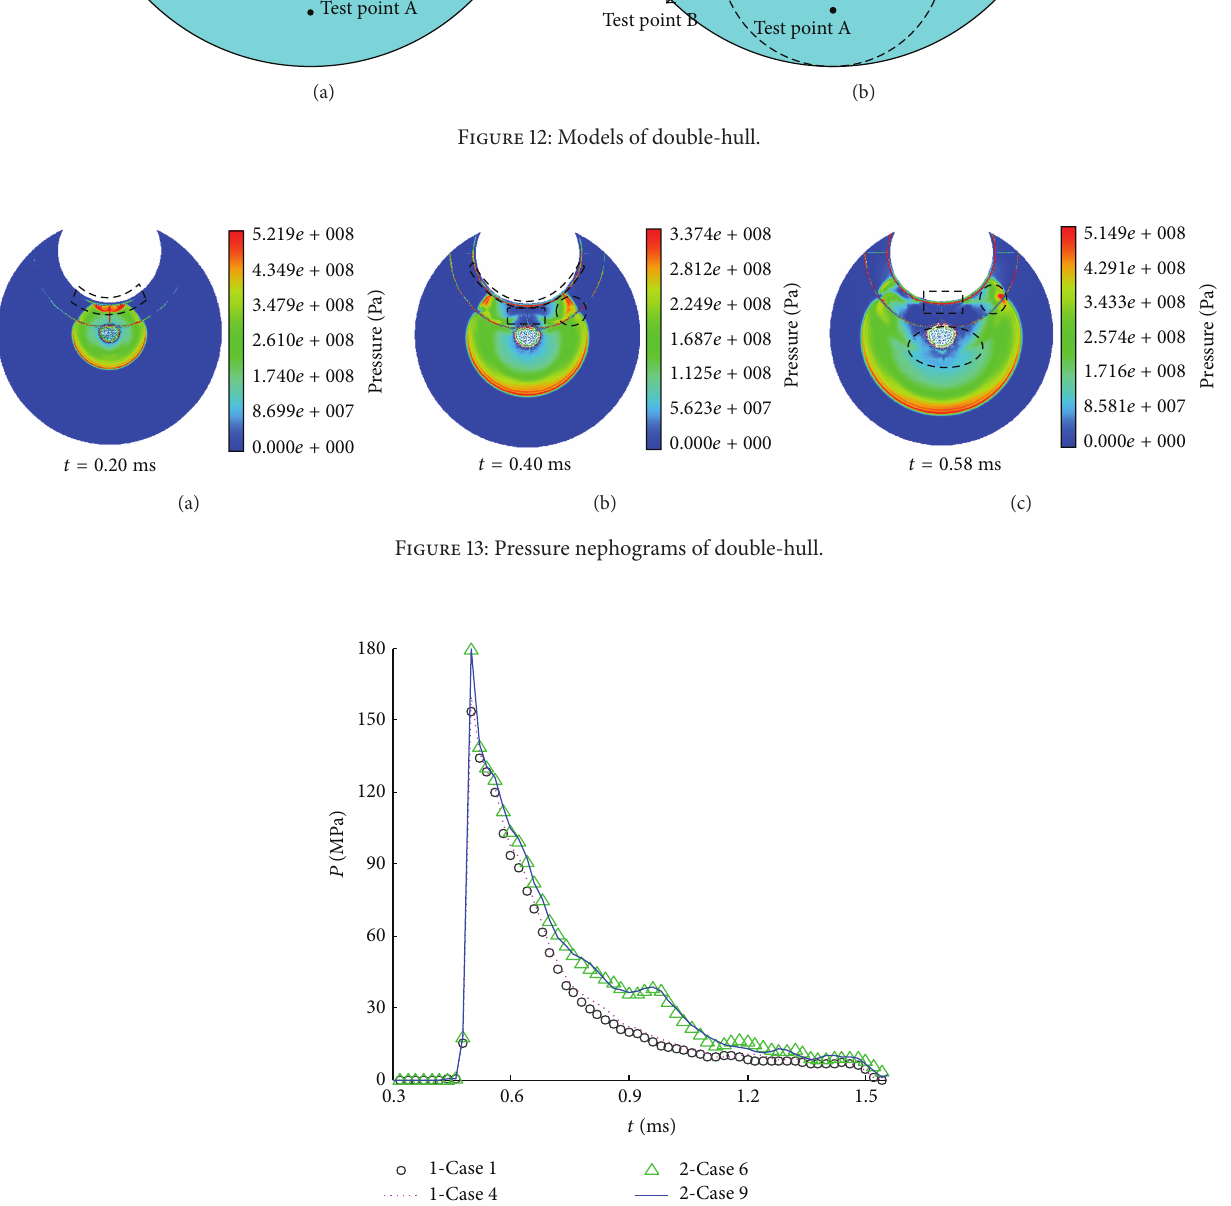
Figure 14: The pressure of test point A; 1 and 2 mean no interlayer water and full interlayer water; cases are shown as Table